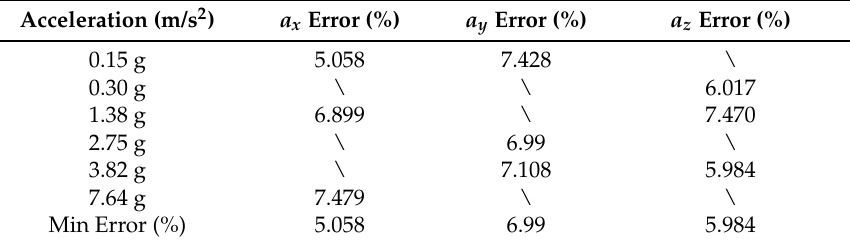
Table 7. Measurement precision of another parallel type six-axis